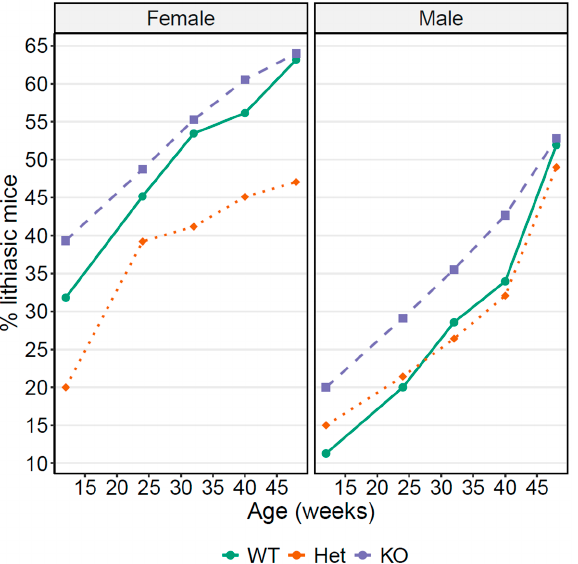
Figure 6. Percentage of lithiasic mice depending on Slc22a4 genotype in a cystinuric ( Slc7a9 − / − ) mice. The percentage of lithiasic mice in a cystinuric Slc7a9 − / − genotype mice depending on Slc22a4 genotype distributed by sex. WT mice are Slc7a9 − / − Slc22a4 +/+ (green, solid line); Het mice are Slc7a9 − / − Slc22a4 +/ − (orange dotted line); and KO mice are Slc7a9 − / − Slc22a4 − / − (blue dashed line). Table 1 shows the number of mice per condition and age.